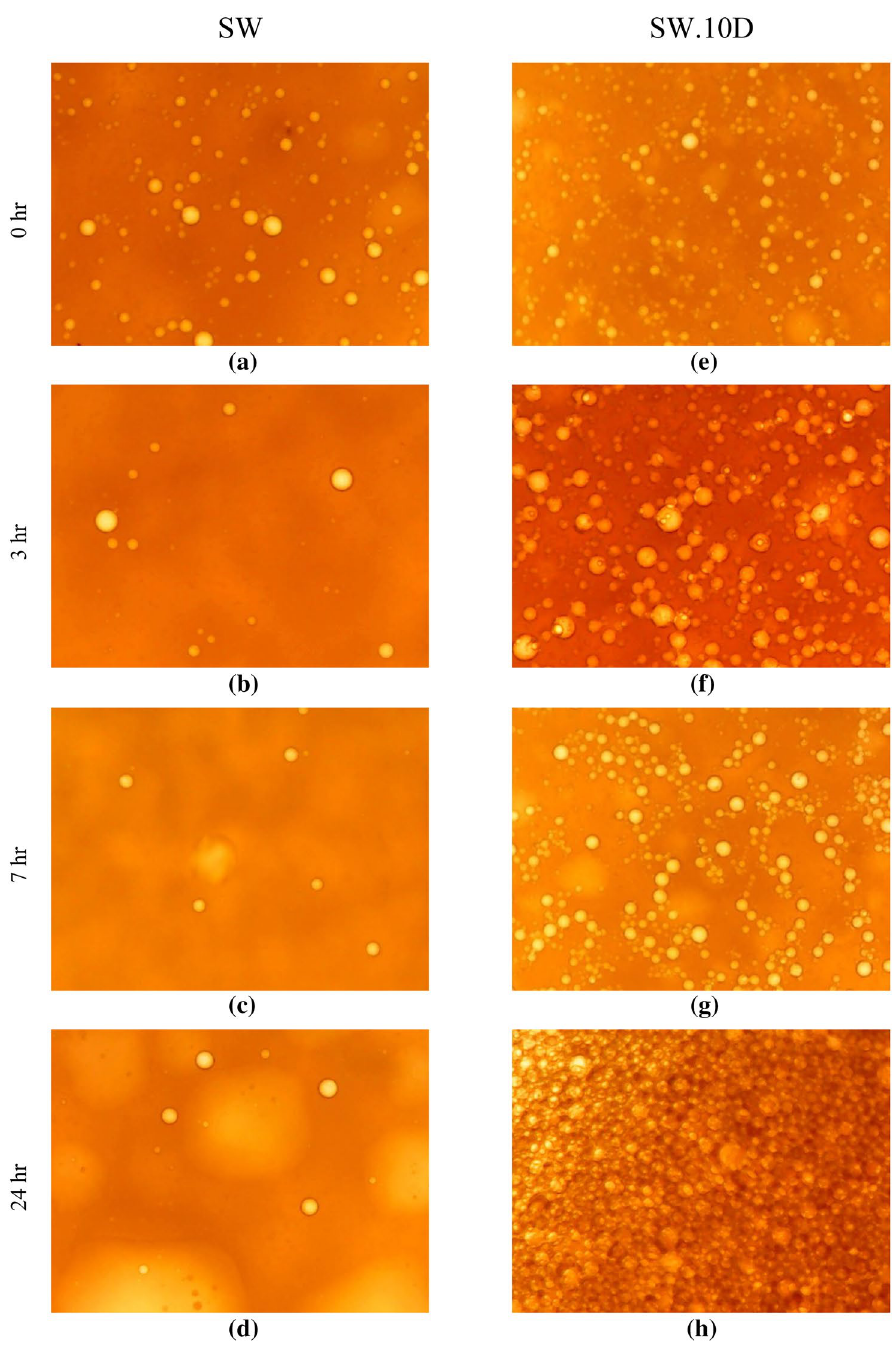
Fig. 5 Comparison of emulsion stability for SW and SW.10D. a SW after 0 h, b SW after 3 h, c SW after 7 h, d SW after 24 h, e SW.10D after 0 h, f SW.10D after 3 h, g SW.10D after 7 h, h SW.10D after 24